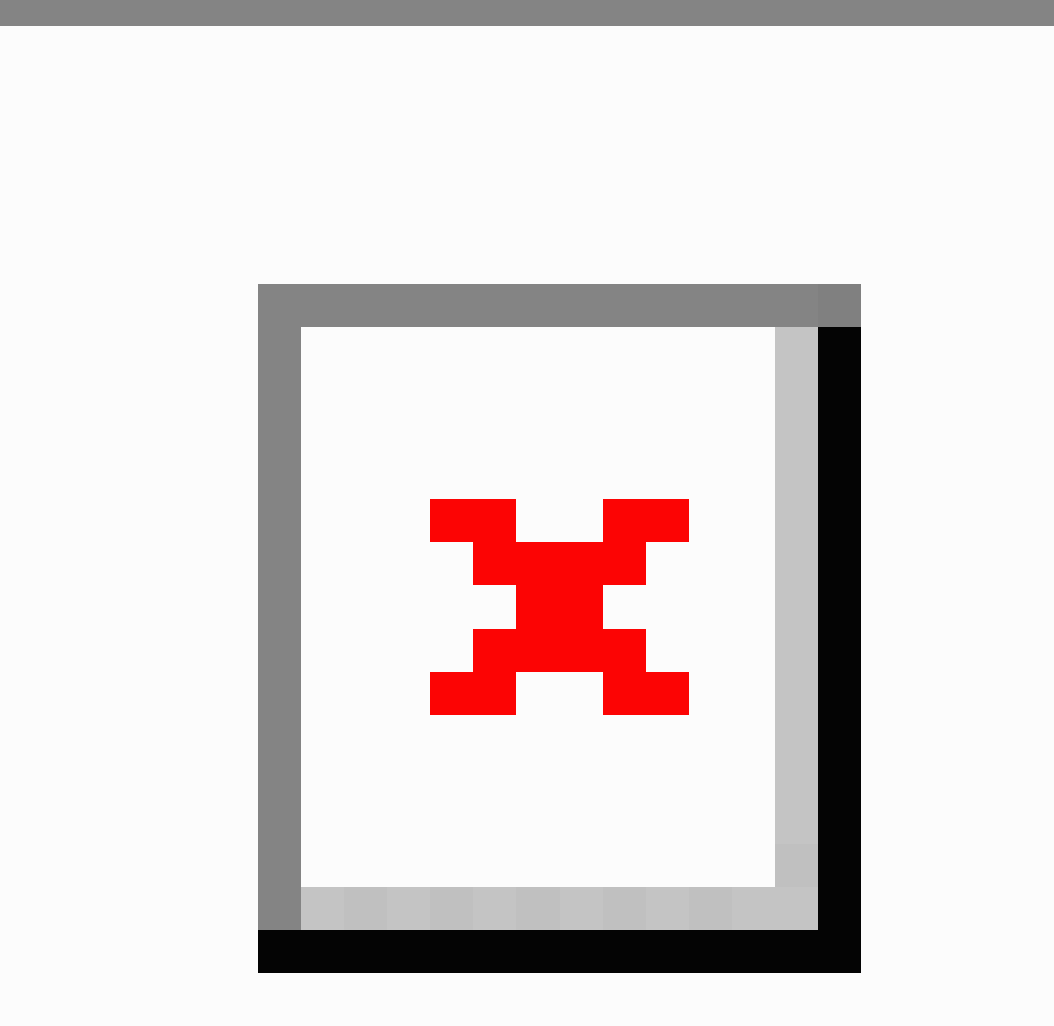
Figure 1. The overall architecture of our model. Bi-LSTM: bi-directional long short-term memory; GCN: graph convolutional network; POS: part-of-speech; MLP: multilayer perceptron; sub: subject; obj: object; hc: representation of chemical; hs: representation of sentence; hp: representation of protein; f: max-pooling